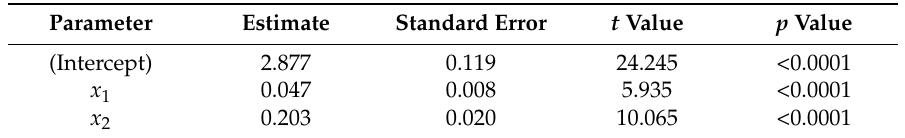
Table 3. Results from linear regression